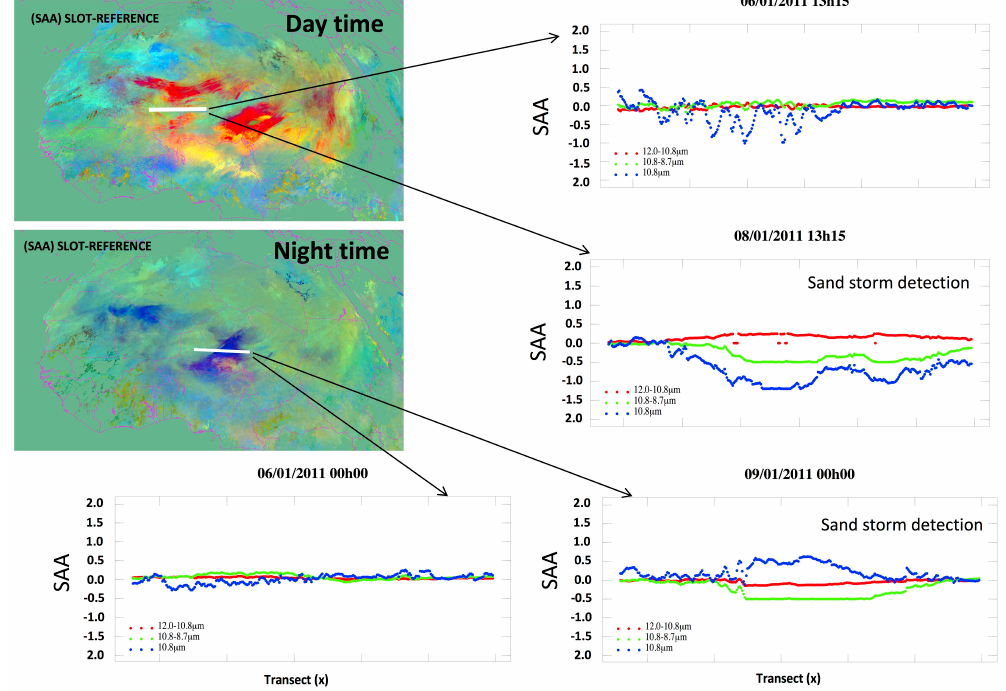
Figure 5. Plots of SAA values in Ww·sr − 1 ·m − 2 (in red, 12.0–10.8 µm, in green 10.8–8.7 µm, and in blue 10.8 µm) across spatial transects in the Sahara area (marked as bold white lines) for a sandstorm free day (6 January 2011) and stormy days (8 January 2011) in daytime and (9 January 2011) in nighttime.